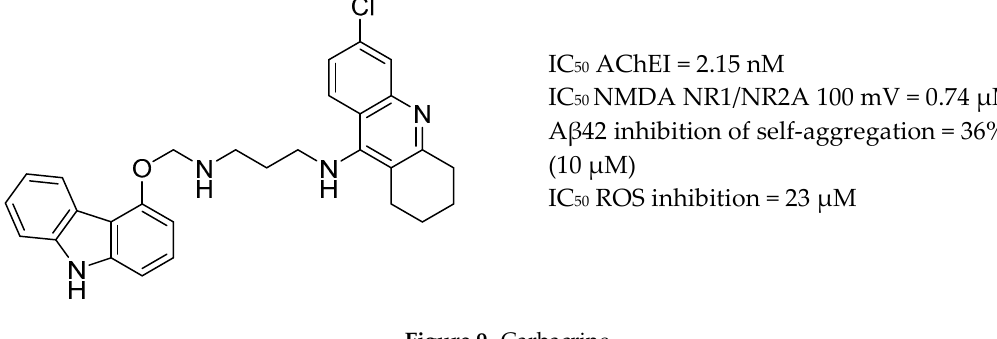
Figure 9. Carbacrine.